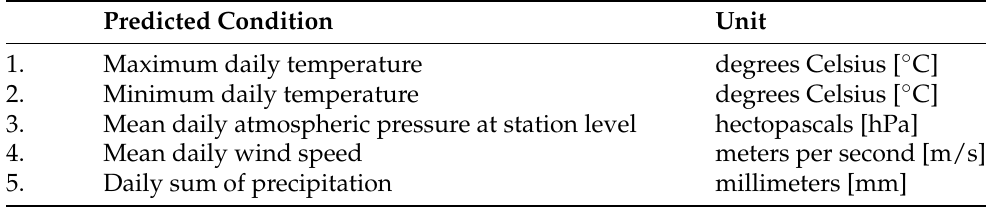
Table 3. The weather conditions selected for the prediction in the MLP